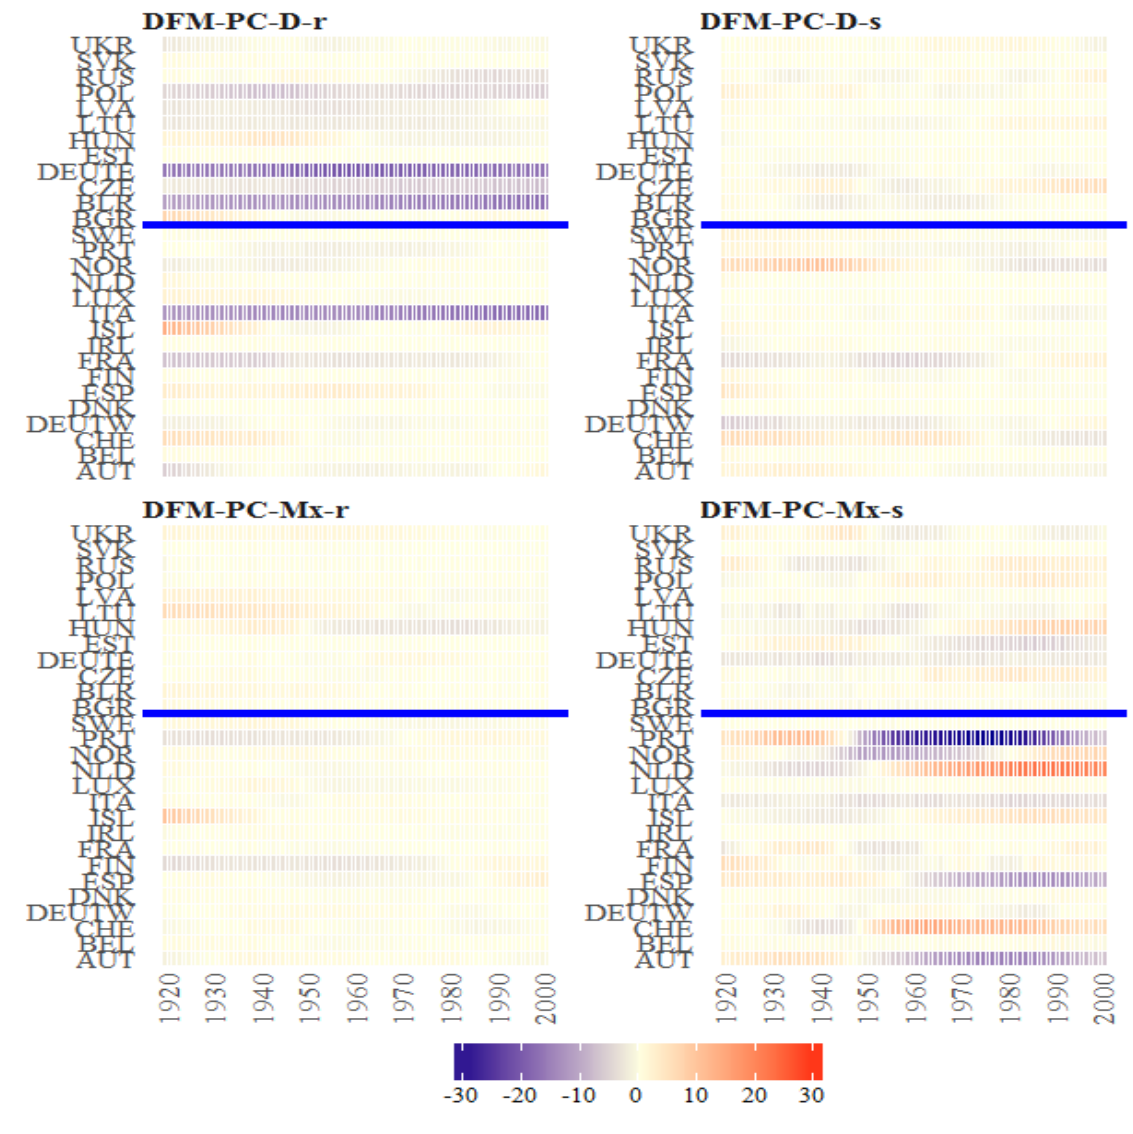
Figure 35. The Bayesian posterior mean estimates for (cid:36) t across countries (y axis) over time (x axis) under the models from the classes DFM-PC-D and DFM-PC-Mx for British female log death rates during 1922–2002. The vertical blue line divides sets into developed (on the left side) and developing (on the right sie) European